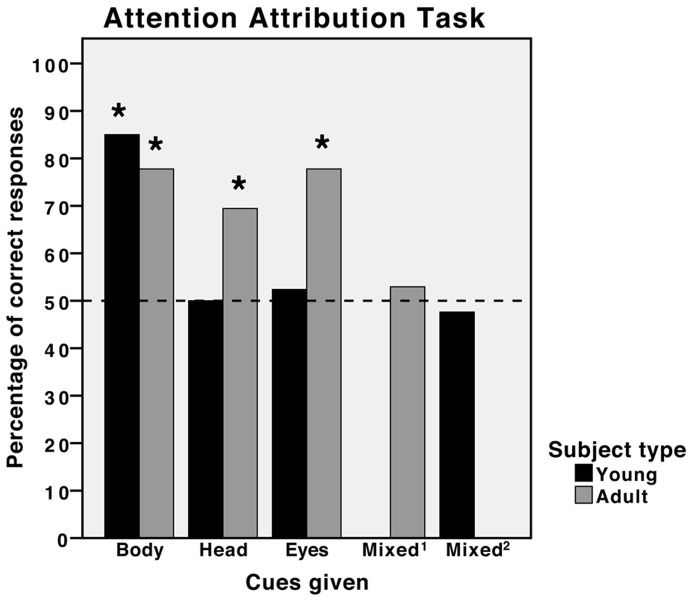
Comparison of the performances of young and adult horses in an attention attribution task.Percentage of correct responses for each cue type for both the youngsters in this study and adult horses reported in the study by Proops and McComb [14]. *  = p<0.05 (binomial probabilities, two-tailed predictions). Mixed1 refers to the cue given to adult horses in which body and head cues were conflicting. Mixed2 refers to the cue given to young horses in which head and eye cues were conflicting.